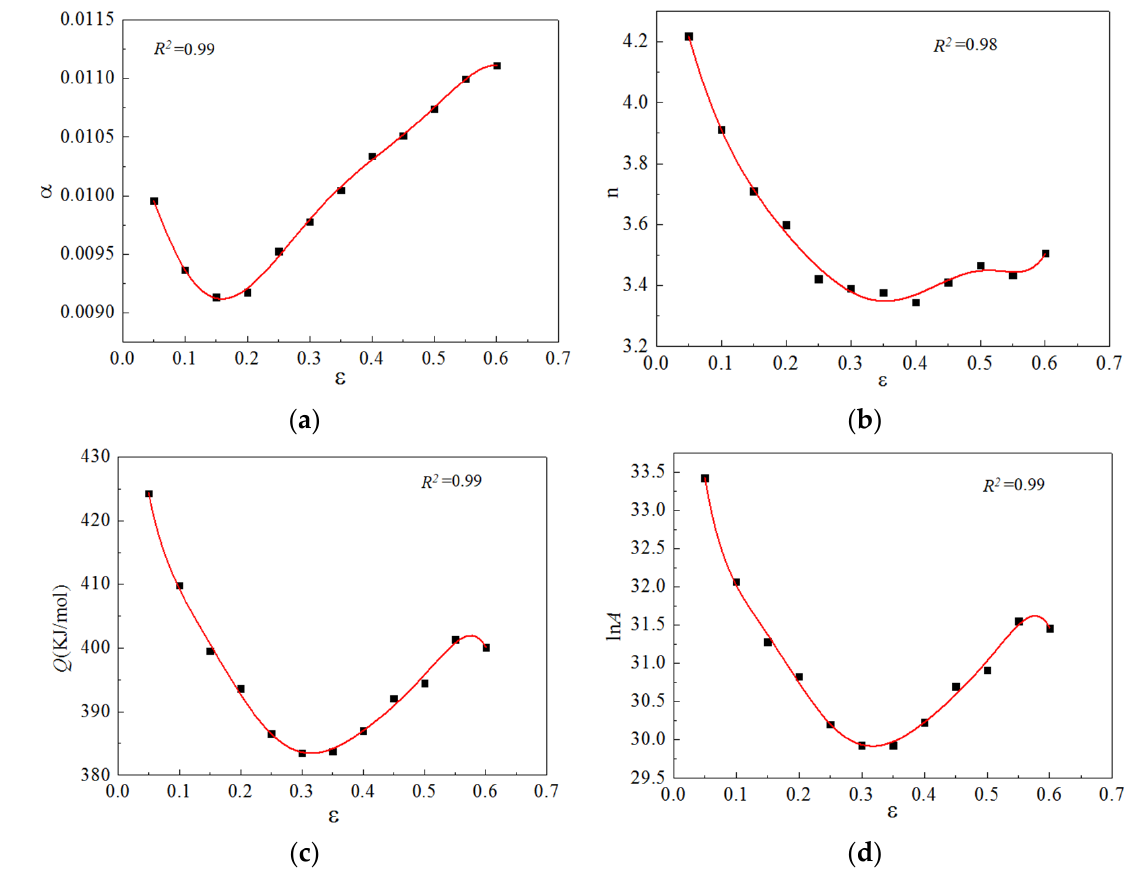
α Figure 10. Polynomial relationship between material parameters and strain ( a ) ( b ) n ( c ) Q ( d ) ln A . Figure 10. Polynomial relationship between material parameters and strain. ( a ) α , ( b ) n , ( c ) Q , ( d ) ln A . The flow stress constitutive equation of GH901 superalloy with a comprehensive As can be seen from Figures 11 and 12, under different strains, the absolute value of consideration of deformation temperatures, strain rates and amount of deformation could the average relative error AARE (%) between the tested stress value and the predicted be obtained from the above calculation, as shown in Equation (9): stress value was 8.123%, which was less than the acceptable error range of 10%. Mean- while, the correlation coefficient R between the tested stress value and the predicted stress value under different strains was 0.992, close to the constant 1. Therefore, the flow stress constitutive equation built under different strain conditions could better realize the prediction of the flow stress of a GH901 nickel-based superalloy under the conditions of deformation temperatures 990–1140 °C and strain rates 0.001–1 s − 1 .